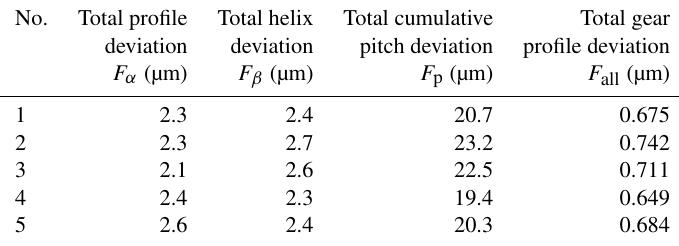
Table 6. Five repeated IGPH experimental results based on the optimization process